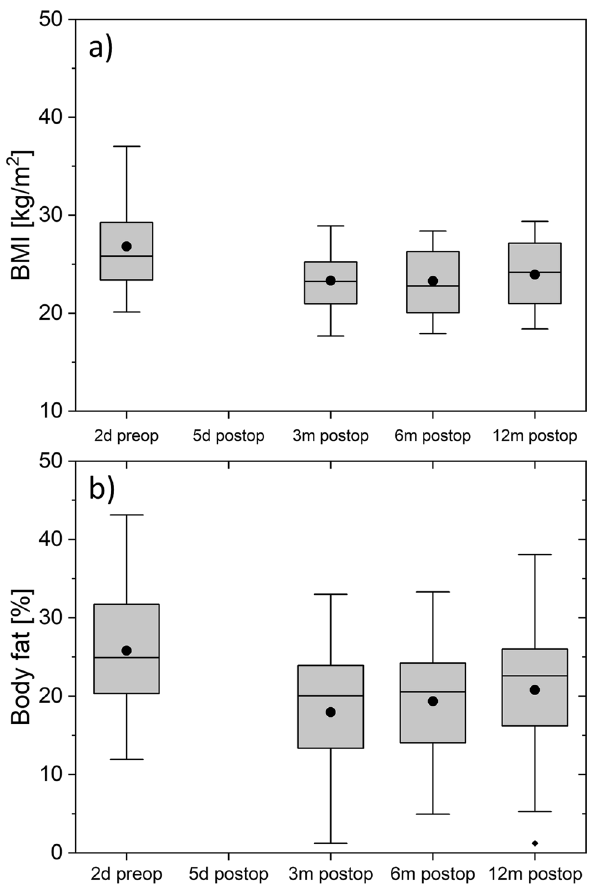
Figure 2. BMI (upper panel) and body fat (lower panel) for each follow-up. The boxes contain the 25% and the 75% quartile as well as the median, black dots depict the mean, and whiskers range from the 5% percentile to the 95%